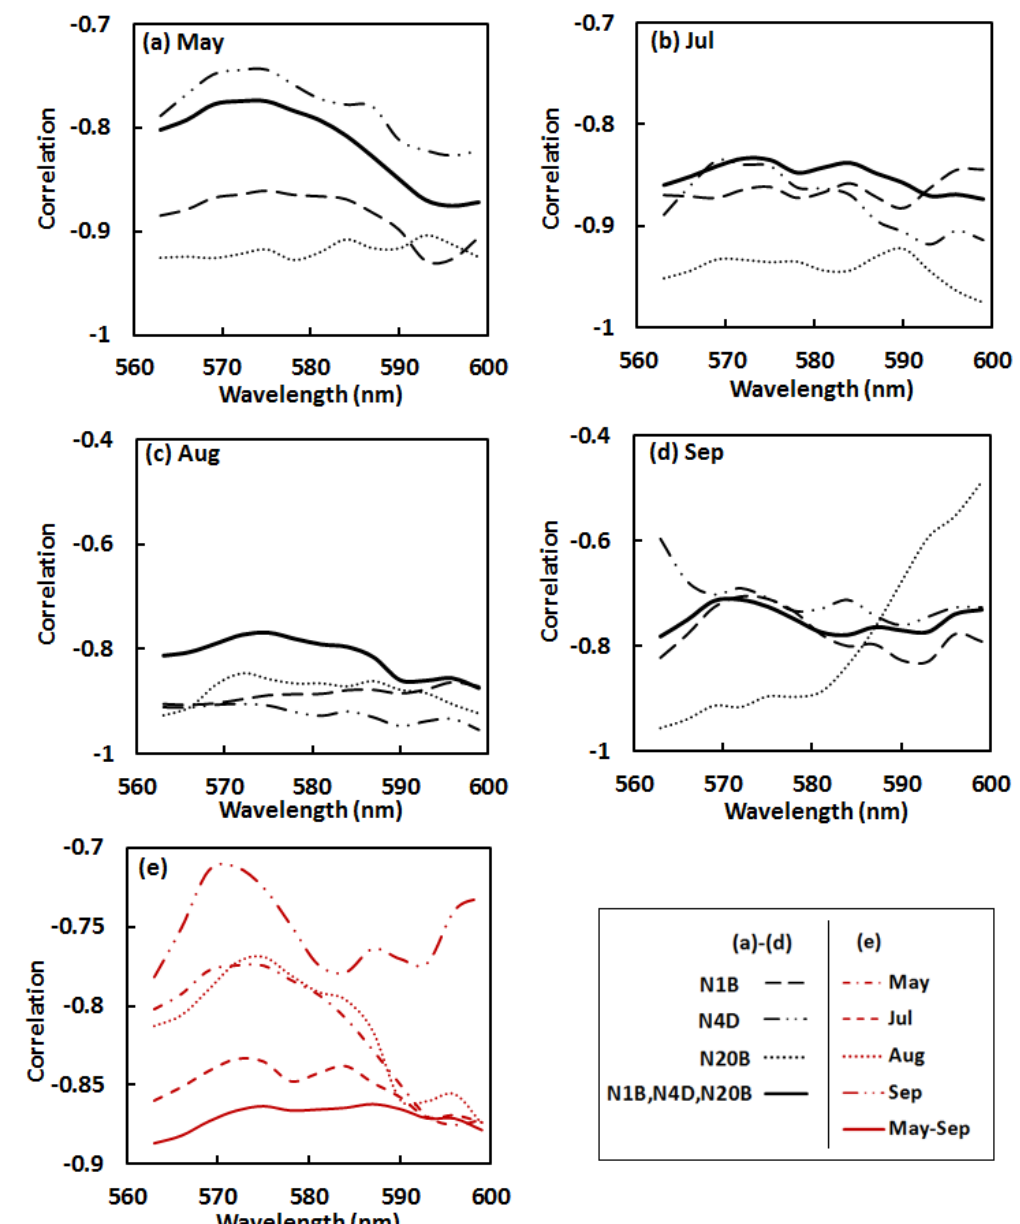
Figure 4. Correlations between canopy nitrogen and the first derivative spectral data at the wavelengths of 562–600 nm for three watersheds N1B, N4D and N20B respectively and as a whole in ( a ) May, ( b ) July, ( c ) August, ( d ) September, and for ( e ) four months respectively and the whole growing seasons in May–September across various